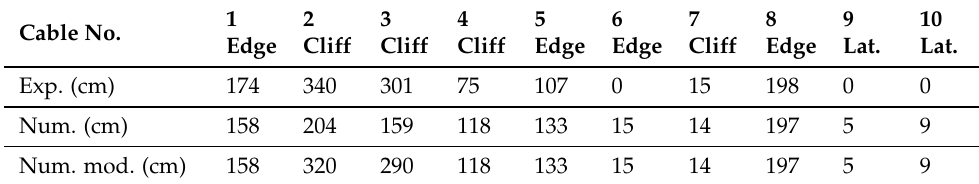
Table 7. Brake elongations by the cable number for the off-centred test. Cable No.